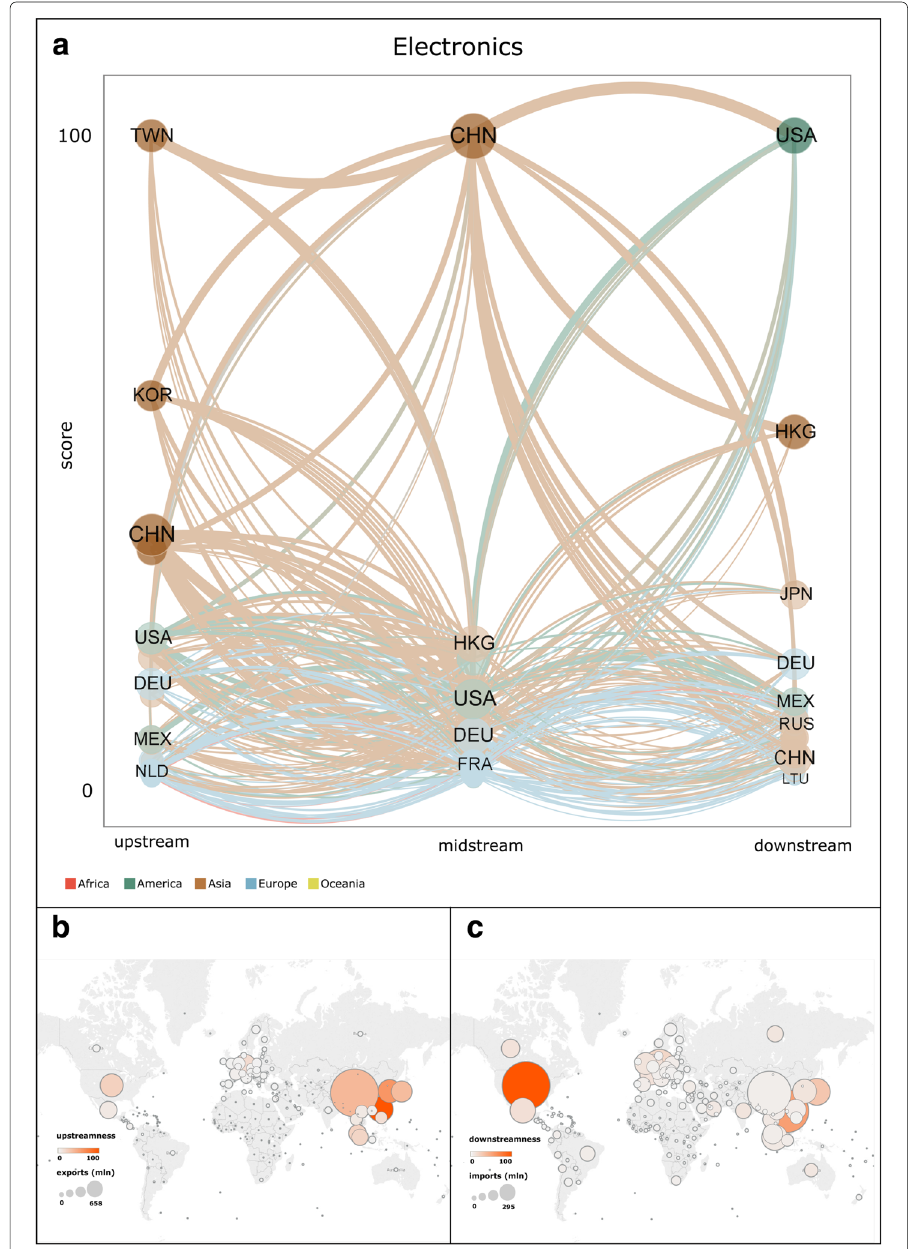
Fig. 5 Rankings and values of upstreamness centrality, midstreamness centrality, downstreamness centrality, exports, and imports of countries in the Electronics industry in 2014. In panel ( a ), the size of each node (country) in the network is proportional to the sum of the country’s exports of intermediate inputs (upstream), the sum of the country’s imports of intermediate inputs and exports of final products (midstream), and the sum of the country’s imports of final products (downstream). For each centrality measure, countries are ranked according to the corresponding score (highest at the top). Each directed link connects a country in set U to a country in set M , or a country in set M to a country in set U , according to the definition of the tripartite network given in the text. The width of each link is proportional to the value of products exchanged by the two connected countries. The colour of each link refers to the continent of the country from which the link originates. Panels ( b ) and ( c ) show the geographic map in which each country is represented as a circle whose diameter is proportional to the country’s total exports (panel ( b )) and total imports (panel ( c )), and whose colour varies according to the corresponding value of upstreamness (panel ( b )) and downstreamness (panel ( c )) centralities. The network in panel ( a ) was visualised through VOS Viewer. Maps in panels ( b ) and ( c ) were visualised using Tableau